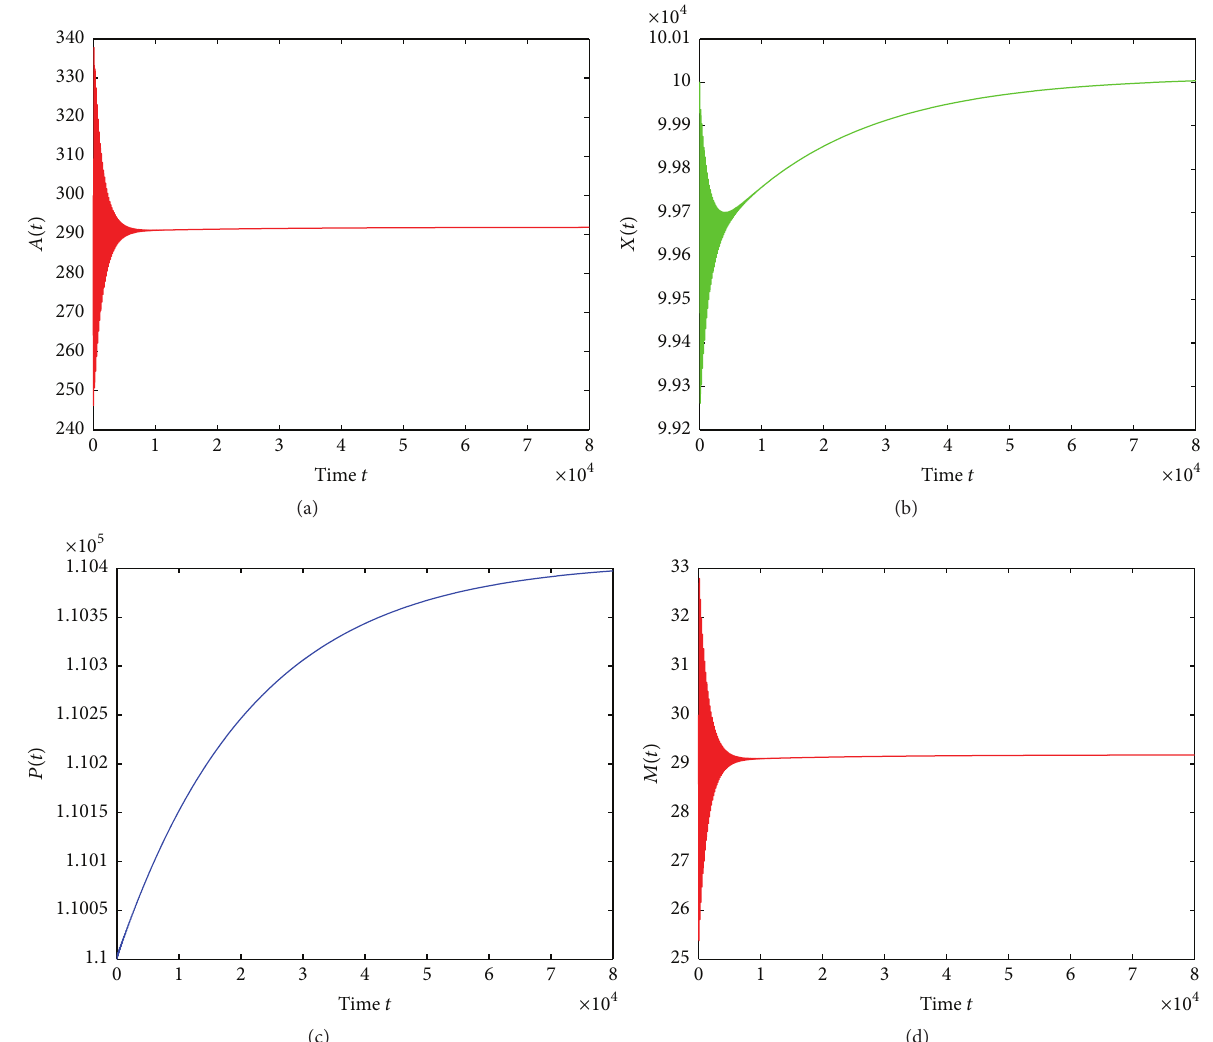
Figure 4: The alcohol equilibrium 𝐸 1 of system (2a), (2b), (2c), and (2d) is locally asymptotically stable with 𝜏 = 1.50 < 𝜏 0 = 1.5767 .